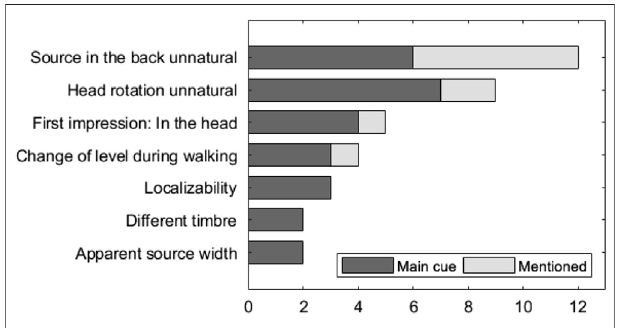
FIGURE 6 | Overview of audible cues reported to be used by the participants to discriminate the binaural simulation from the real sound fi eld.